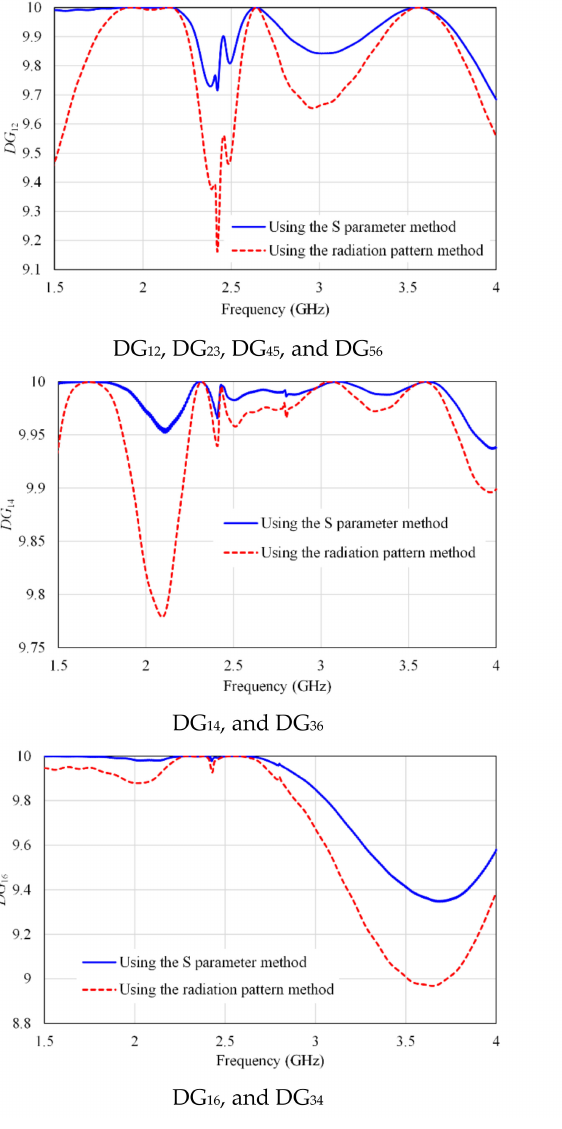
Figure 17. The DG of the proposed MIMO antenna by using the S parameter and radiation pattern methods.